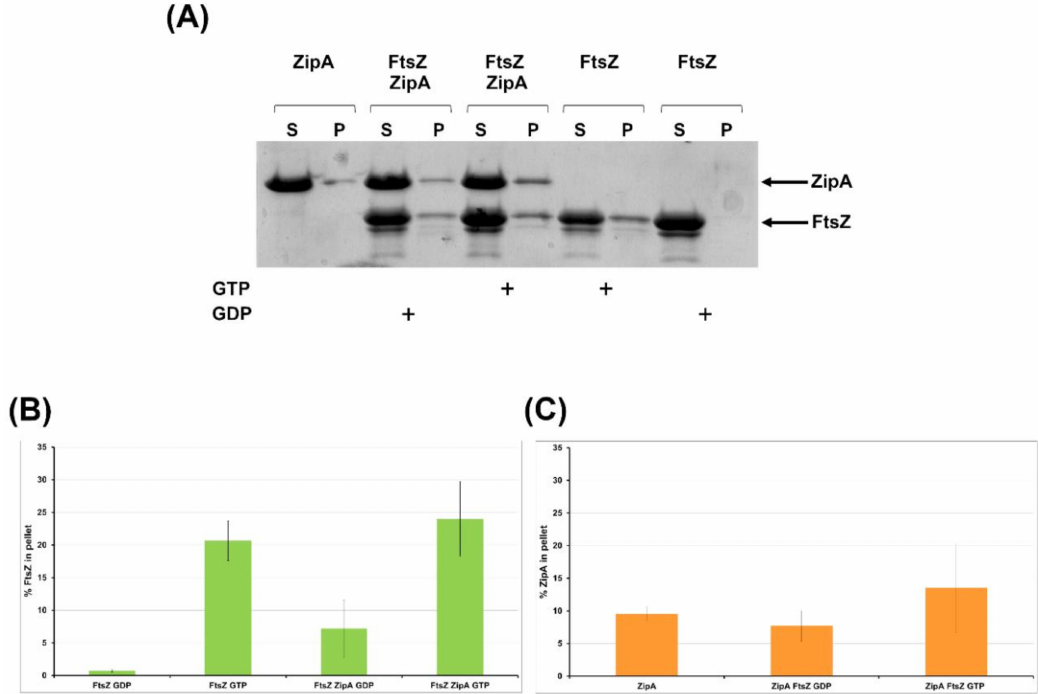
Figure 8. In vitro reconstitution of the FtsZ / ZipA interaction. FtsZ was polymerized in the presence or in the absence of ZipA with GTP or GDP. ( A ) The polymeric FtsZ was collected by sedimentation and the amount of FtsZ in the pellets (P) was estimated by coomassie-blue staining of the SDS-PAGE. S, supernatant. ( B ) and ( C ) The bars indicate the relative quantification of FtsZ ( B ) and ZipA ( C ) percentage in the pellet obtained by densitometry analysis. Data are the average ± SD of three independent